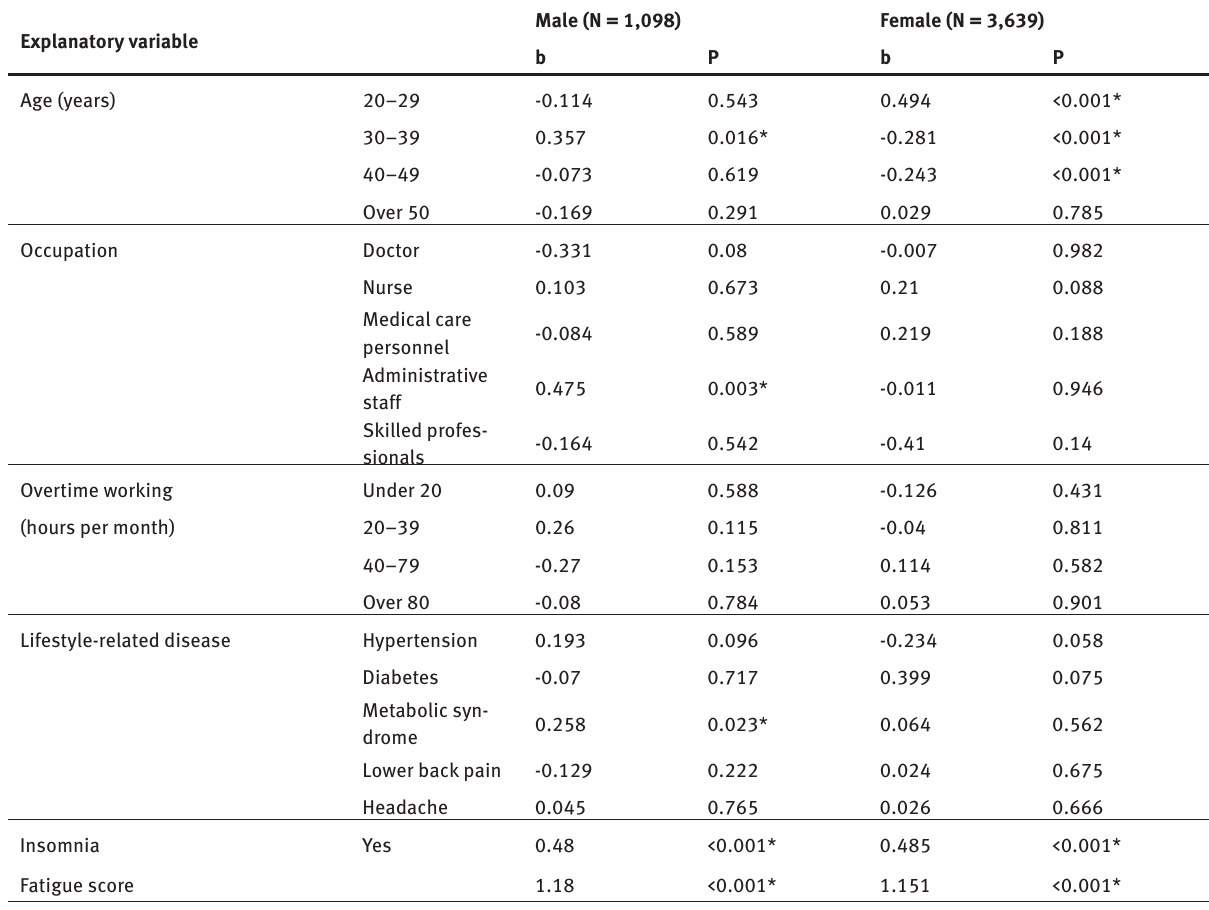
Table 3: Multiple regression analysis by gender with depression criterion variable